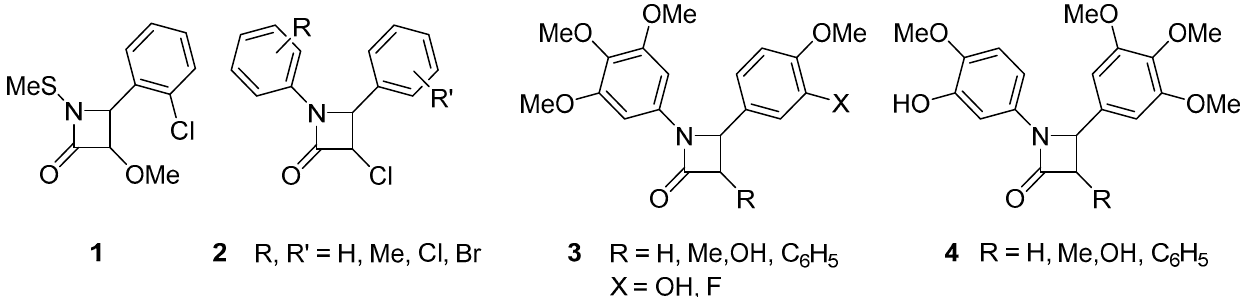
Figure 1. Example of azetidinones exhibiting anticancer activity.